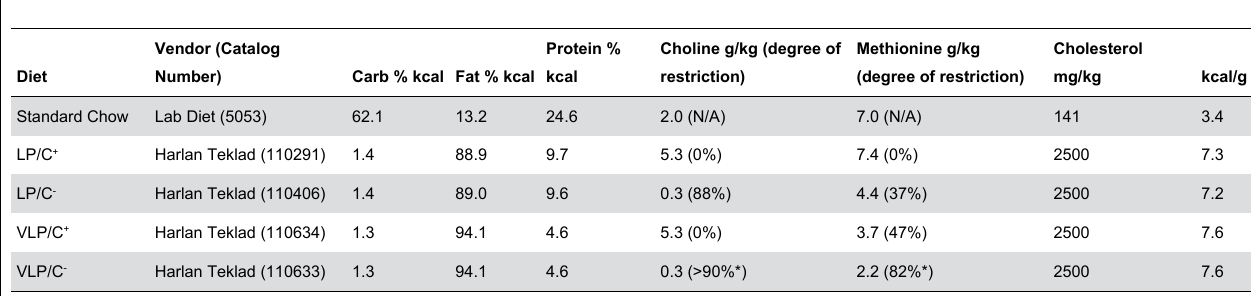
Table 1. Macronutrient composition of mouse diets used in this study.